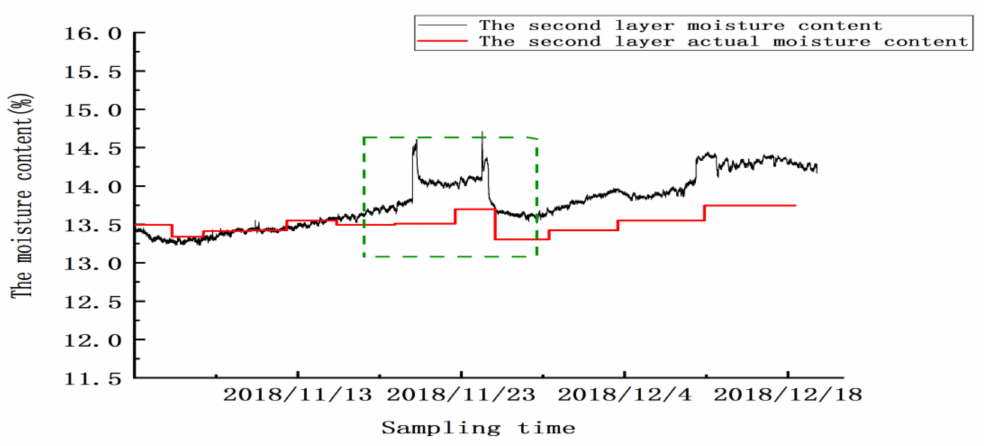
Figure 23. The moisture values of the grain in the second layer.